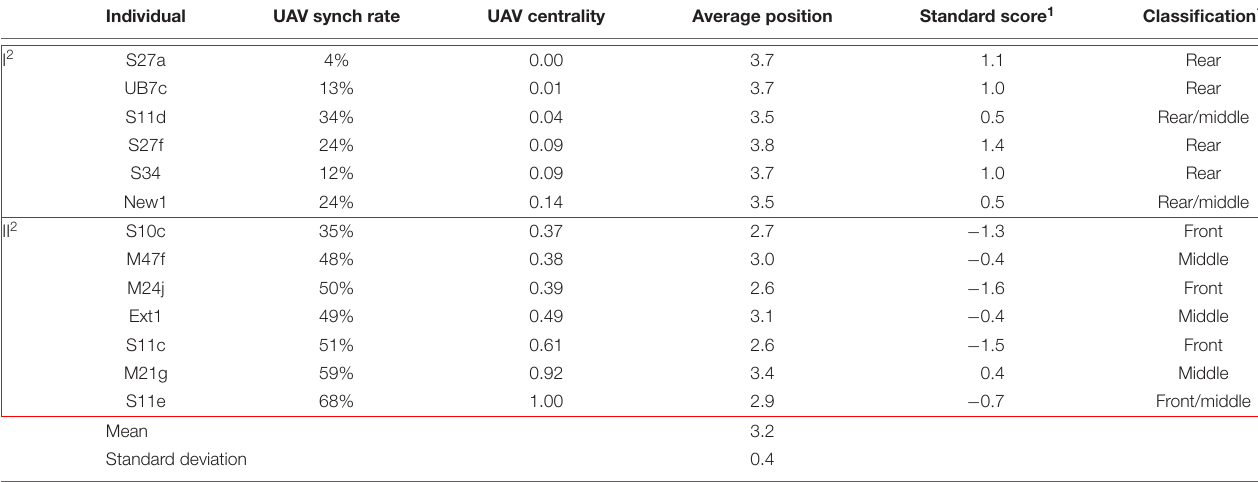
TABLE 2 | UAV synch rate, eigenvector centrality and average position. Individual